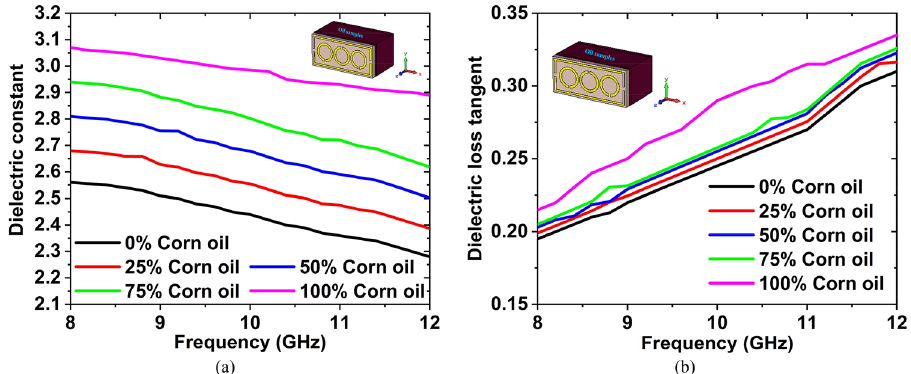
Figure 18. Measured ( a ) Dielectric constant, and ( b ) Loss tangent curves for the different concentration (0%, 25%, 50%, 75%, and 100%) of corn oil in olive oil.